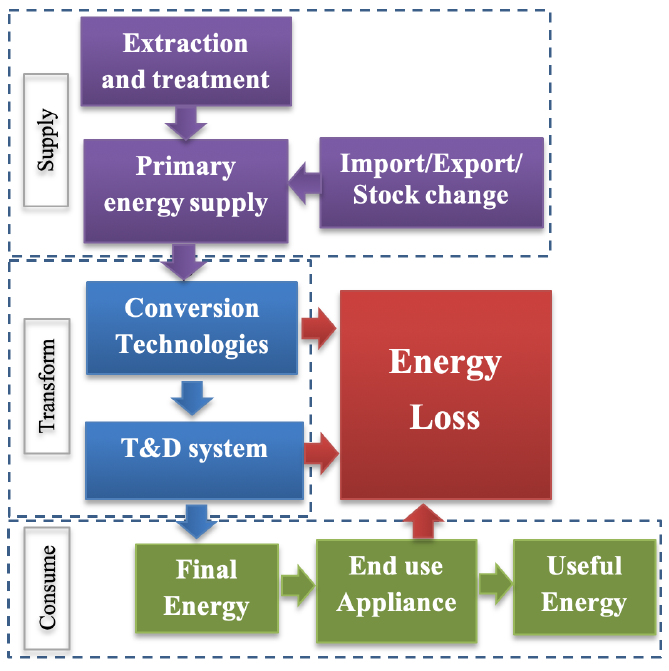
Figure 1. Energy supply